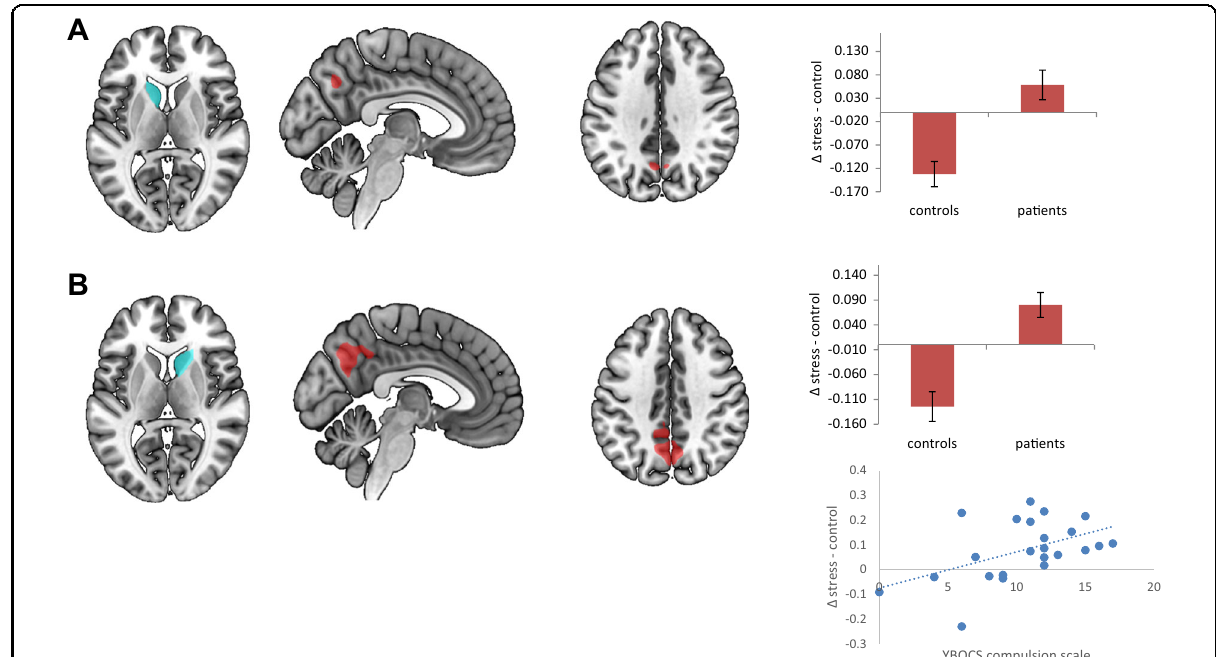
Fig. 3 Stress effects in patients compared to healthy controls with the selected seeds, signi fi cant connectivity results (thresholded at p > 0.001 for illustrational purposes), contrast estimates extracted from the signi fi cant clusters, and correlation with compulsion scale of the YBOCS. a Seed region: left caudate nucleus; OCD patients >healthy controls (stress >control condition). b Seed region: right caudate nucleus; OCD patients >healthy controls (stress >control